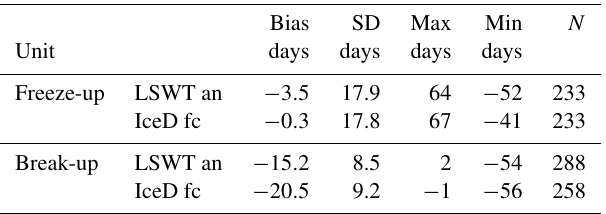
Table 3. Statistical measures of the error of freeze-up and break-up dates.